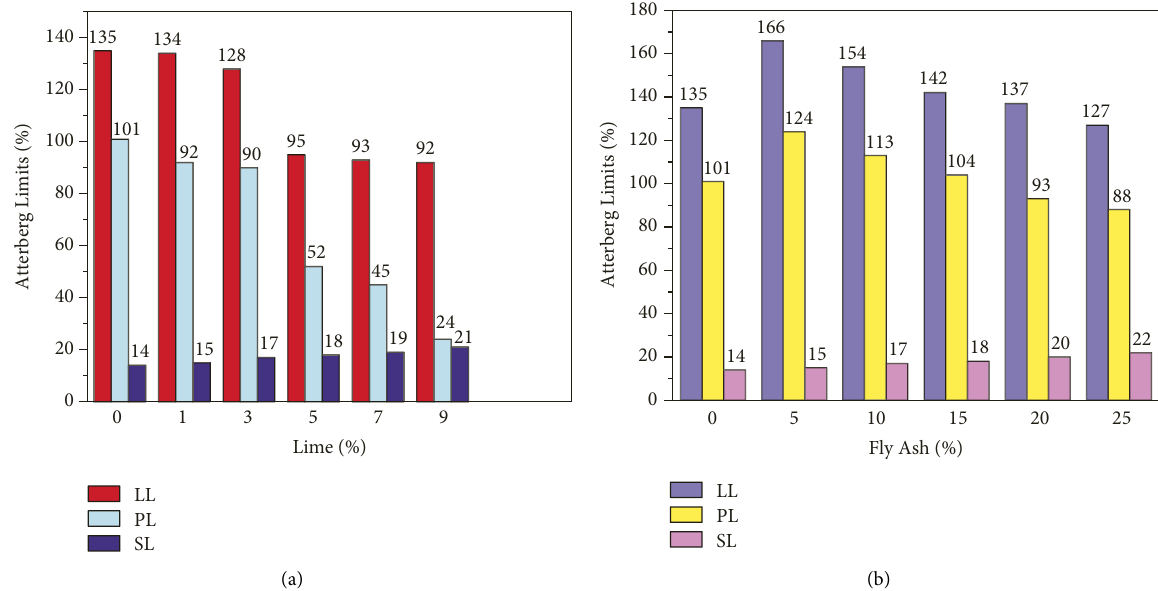
Figure 6: Variation in the Atterberg limits, i.e., LL (liquid limit), PI (plasticity index), and SL (shrinkage limit), with increasing lime and fly ash contents. (a) lime; (b) fly